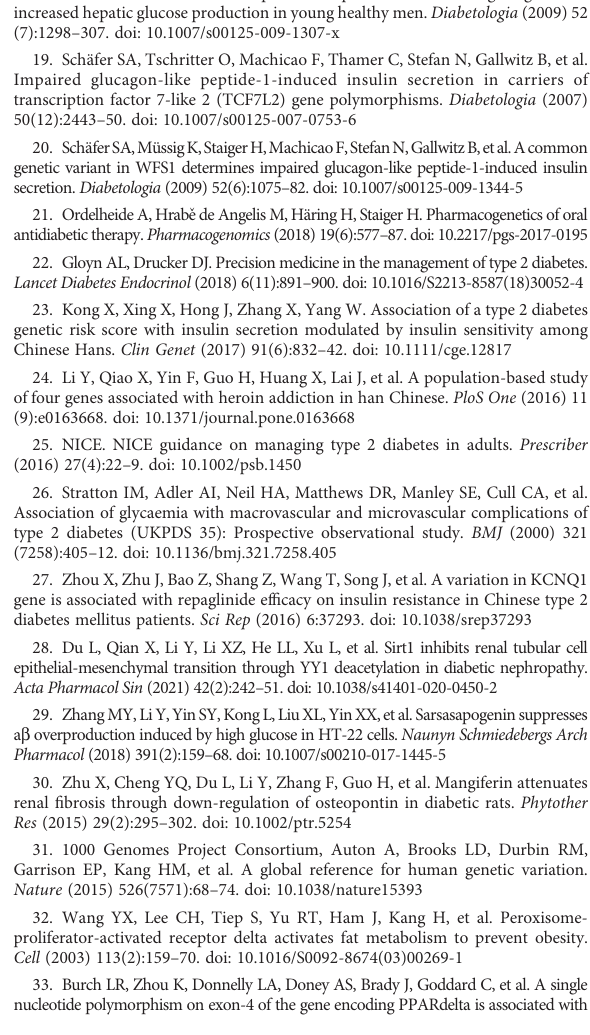
SUPPLEMENTARY FIGURE 3 Baseline levels of waisttohip ratio(WHR) (A) , postprandial plasma glucose (PPG) (B) , fasting serum insulin (FINS) (C) and homeostasis model assessment for insulin resistance (HOMA-IR) (D) in T2DM patients with AA(n=95),AG(n=150)orGG(n=55)genotypesof PPARD rs3777744.* P < 0.05, ** P < 0.01 and *** P < 0.001compared with the AAgenotype group (n = 300). SUPPLEMENTARY FIGURE 4 The expression of PPAR d decreased in IR HepG2 cell model and db/db mice. (A) The mRNA level of PPAR d in HepG2 cells was measured by RT- PCR. Data are expressed as the mean ± SE, n = 3. (B) The relative protein expression level of PPAR d in HepG2 cells was measured by Western blot.